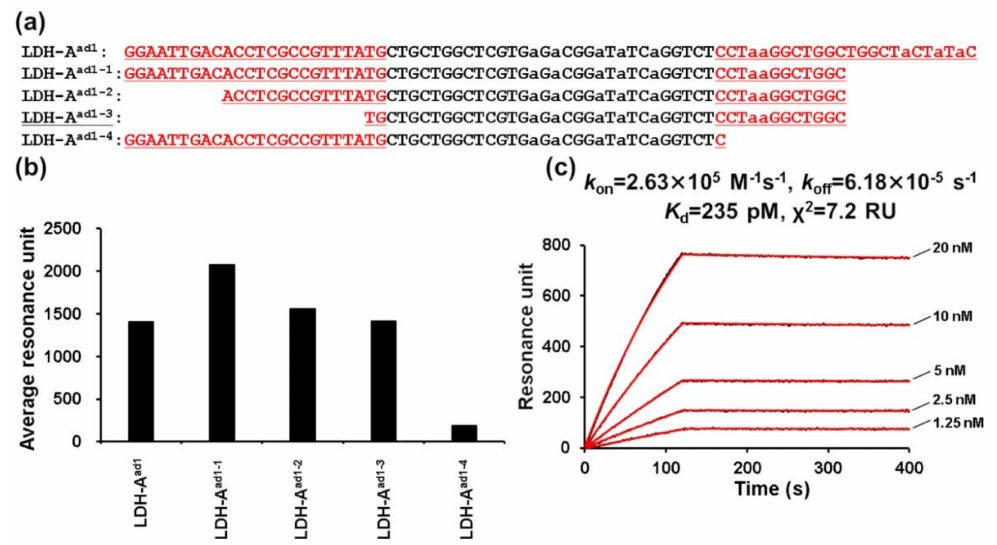
Figure 4. LDH–A ad1 truncated aptamer preparation. ( a ) Sequences of the LDH–A ad1 truncated aptamers. Sequences are aligned in the 5 (cid:48) to 3 (cid:48) direction. Underlined regions derive from the primer or primer-binding regions. The letter “a” indicates A ad . ( b ) SPR response units of the interaction between the LDH-5 and the LDH-A ad1 truncated aptamers. Measurements were performed with multicycle kinetics, and LDH (400 nM) was injected over the respective aptamer-immobilizing sensor chips for 120 s at a flow rate of 50 µ L / min. SPR response units between 115–125 s, which were in the plateau region of the sensorgram curves, were averaged. ( c ) Representative SPR sensorgrams showing the interaction between the LDH-5 and the aptamer LDH–A ad1-3 . Various concentrations of LDH-5 (1.25–20.00 nM) were injected over the respective LDH-A ad1-3 -immobilizing sensor chip for 120 s at a flow rate of 50 µ L / min. The black line represents the measured curve, and the red line represents the fitting curve. The average of the squared di ff erences between the measured data points and the corresponding fitted values are represented as χ 2